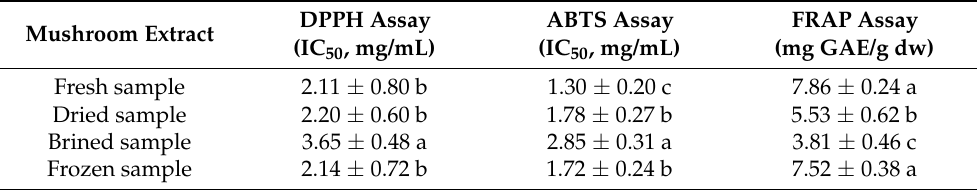
Table 3. Antioxidant assay of the methanolic extracts obtained from different tropical black bolete